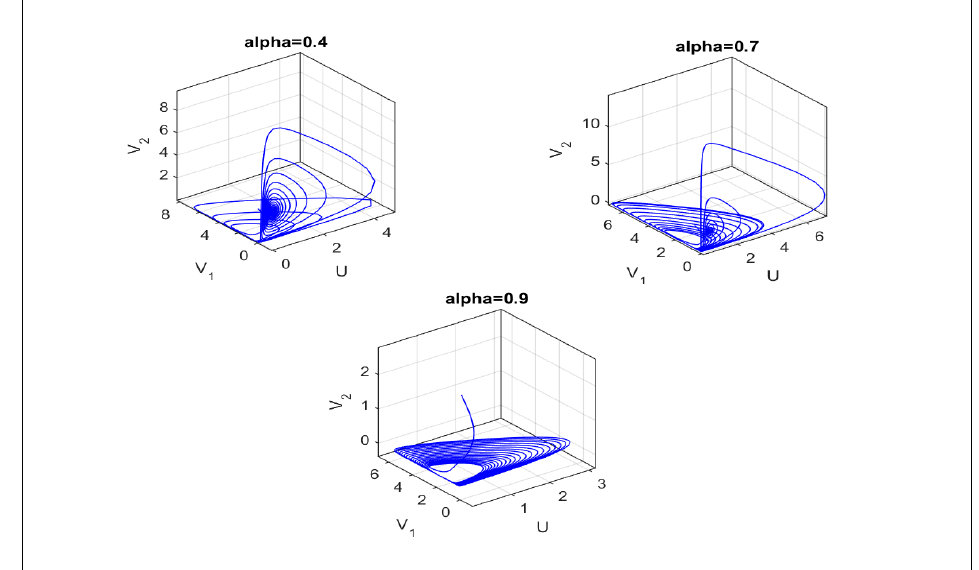
Figure 1. Phase Portraits different values of fractional parameter α .